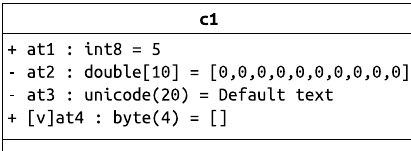
Fig. 7. Graphical representation of a collection ( Coll ) with attributes ( Attr ).